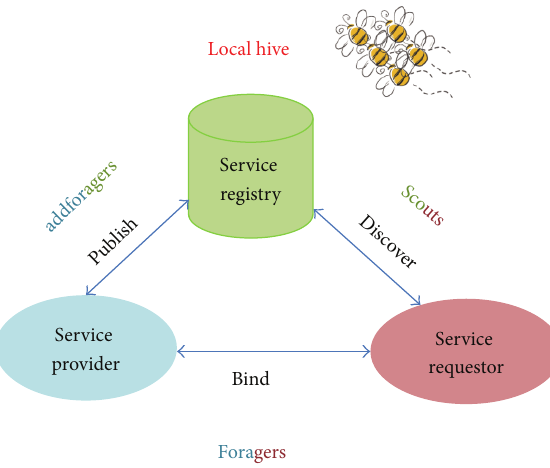
Figure 3: Schematic representation of services and mapping scout- forager into find-bind-publish operations.